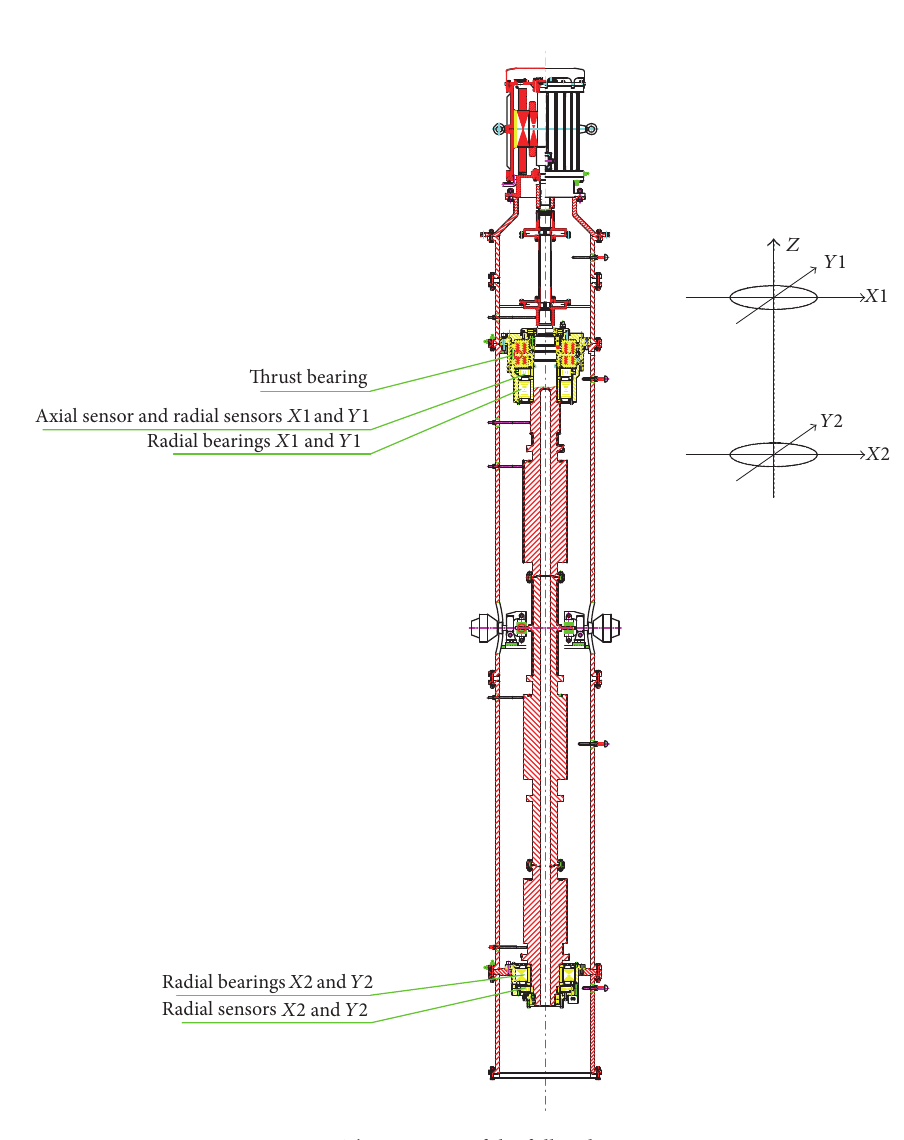
Figure 3: The structure of the full scale test rig.